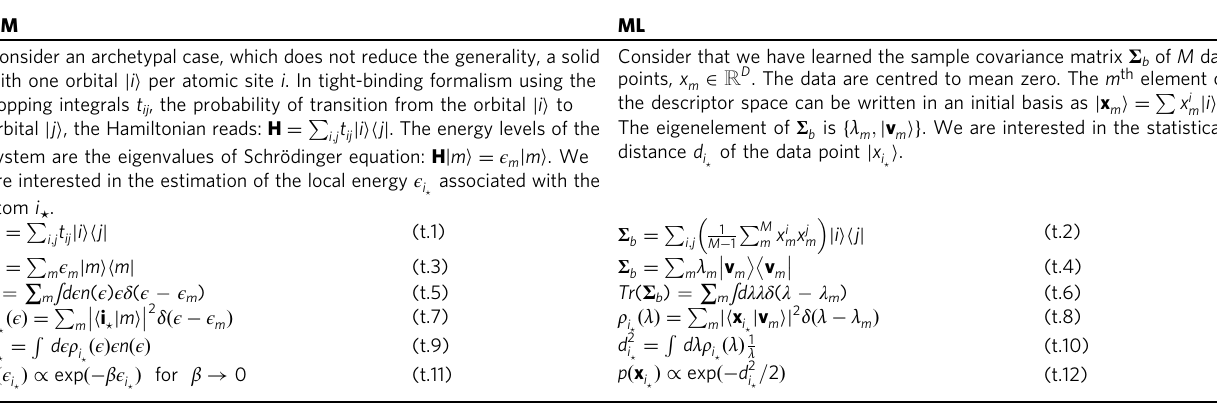
Table 1 Comparison of the quantum mechanics (QM) and machine learning (ML) formalism. QM ML Consider an archetypal case, which does not reduce the generality, a solid with one orbital i j i per atomic site i . In tight-binding formalism using the hopping integrals t ij , the probability of transition from the orbital i j i to P t i j i j h j . The energy levels of the orbital j j i , the Hamiltonian reads: H ¼ ij i ; j